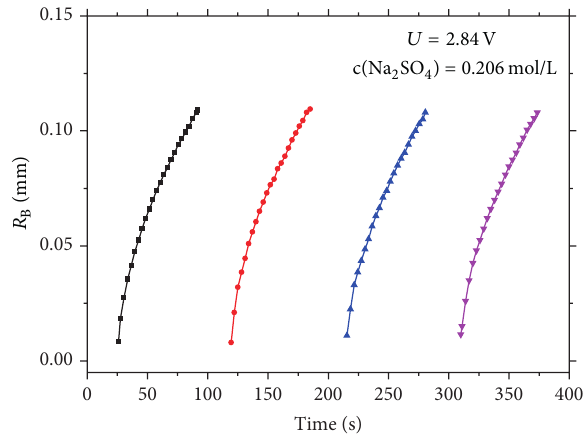
Figure 4: Bubble growth characteristics under 𝑈 = 2.84 V and c(Na 2 SO 4 ) = 0.206 mol/L (colorful lines stand for different growth periods).